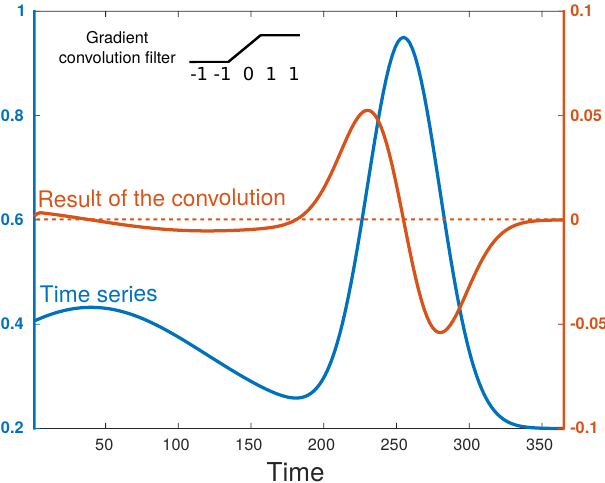
Figure 3. Convolution of a time series (blue) with the positive gradient filter [ − 1 − 1 0 1 1 ] (black). The result (red) takes high positive values when the signal sharply increases, and